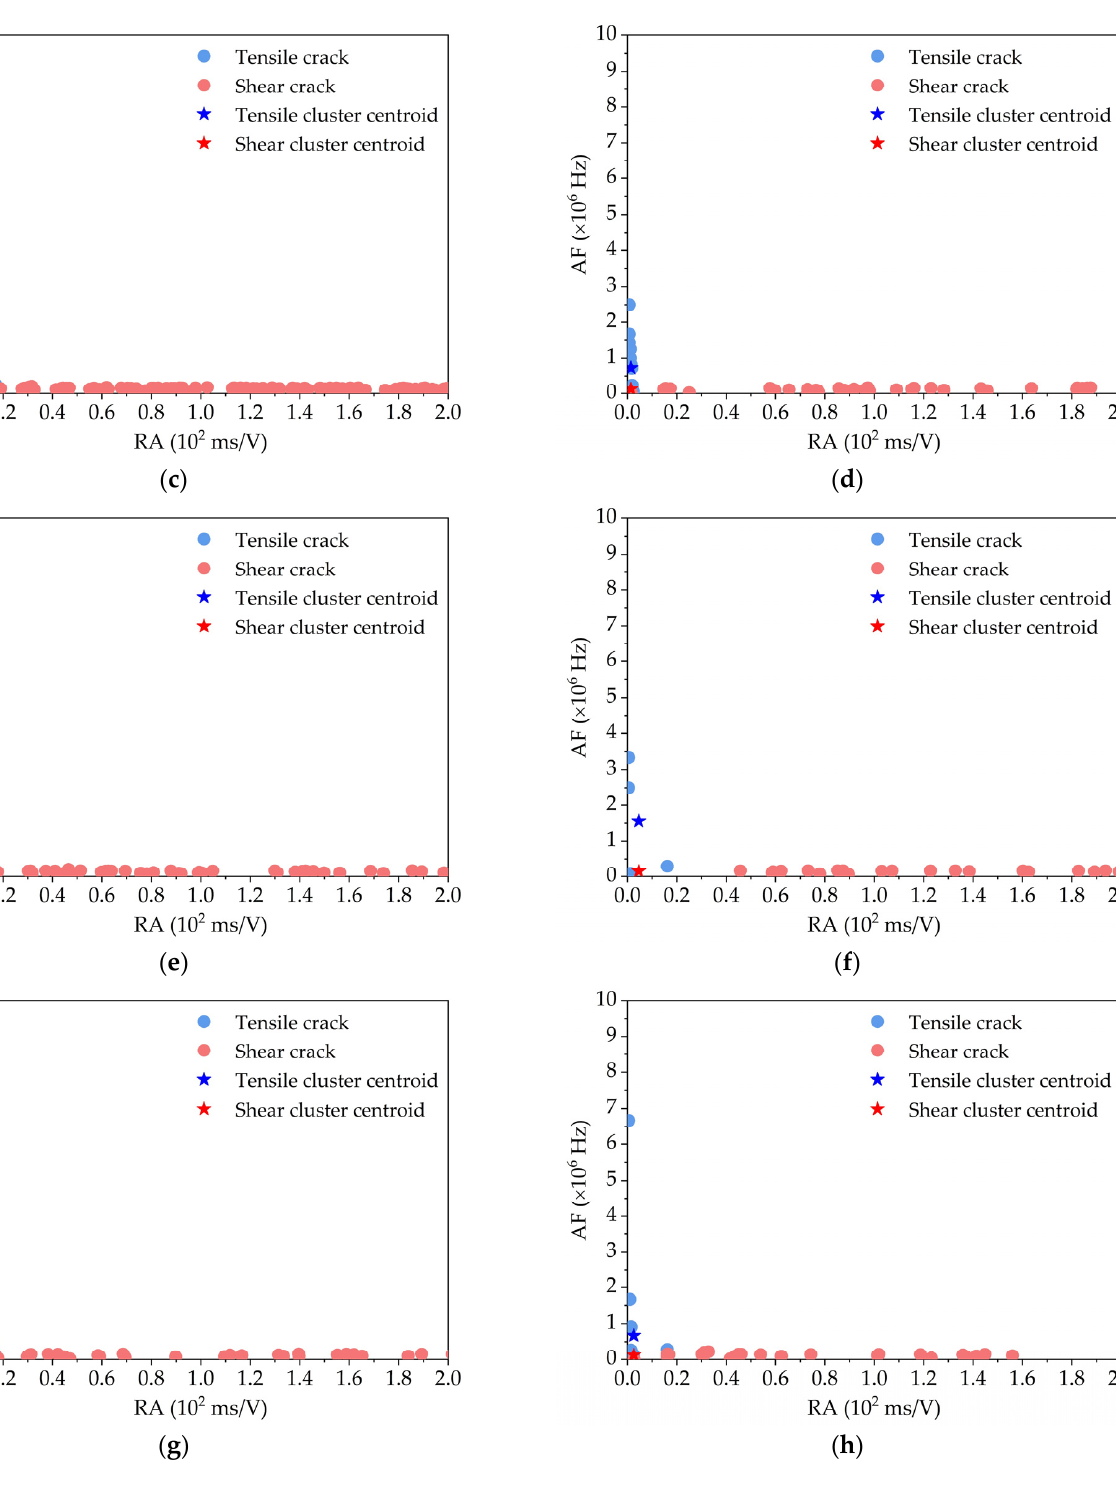
Figure 9. Tensile fracture mode classification based on the AE indirect parameters for asphalt mixture subjected to F-T conditions: ( a ) 0 cycle; ( b ) 3 cycles; ( c ) 6 cycles; ( d ) 9 cycles; ( e ) 12 cycles; ( f ) 15 cycle; ( g ) 18 cycles; ( h ) 21 cycles.